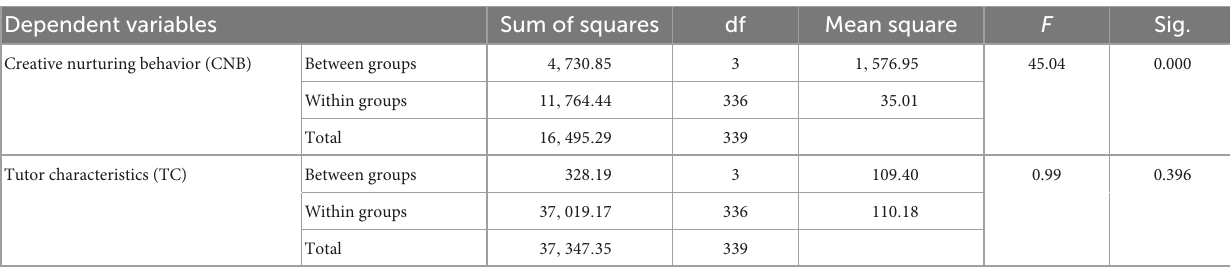
TABLE 5 ANOVA results.